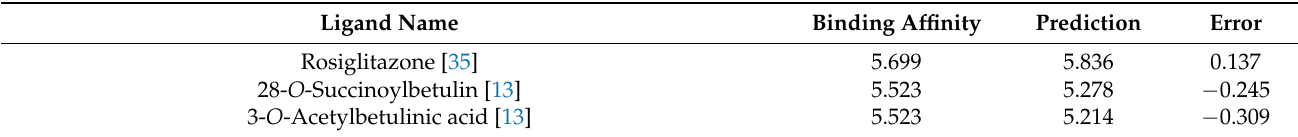
Table 1. Training set to generate an atom-based QSAR model for anti-preS1 activity. Listed are experimentally determined binding affinities ( − log (IC 50 M)) of ligands and predicted binding affinities by the resulting QSAR model. Error describes the difference from the experimentally determined to the predicted binding affinity. Previous descriptions of the compounds as NTCP inhibitors are referenced. As an exception, the arylmethylamino “steroid” compounds are introduced here as novel NTCP inhibitors for the first